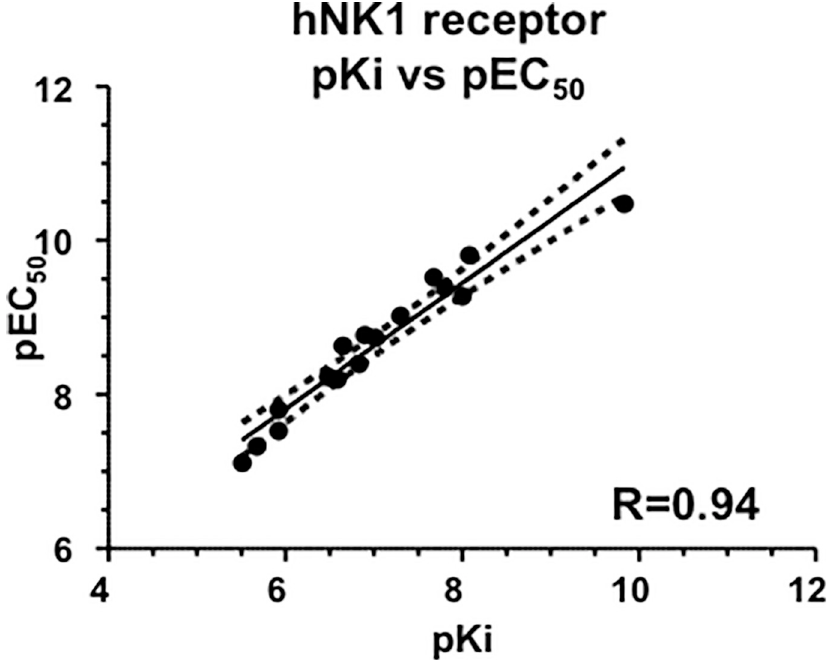
Fig 11. Correlation between displacement of [ 3 H]-Septide binding (pKi) and intracellular calcium response (pEC 50 ) at human recombinant NK1 receptors expressed in CHO cells. Scatterplot and regression analysis of pKi versus pEC 50 values at human recombinant NK1 receptors for a series of NK2 agonists. Solid line: regression analysis; dotted lines: 95% confidence intervals.